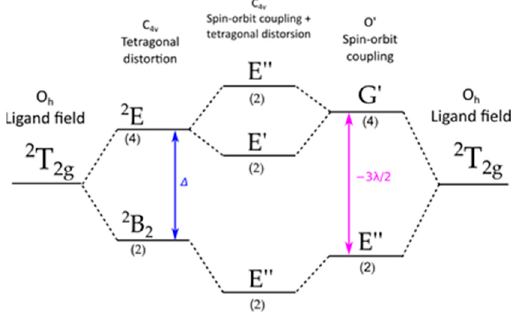
Figure 6. Splitting of the 2 T 2 term by spin-orbit coupling and a tetragonal distortion. Numbers in parentheses correspond to the degree of orbital degeneracy.